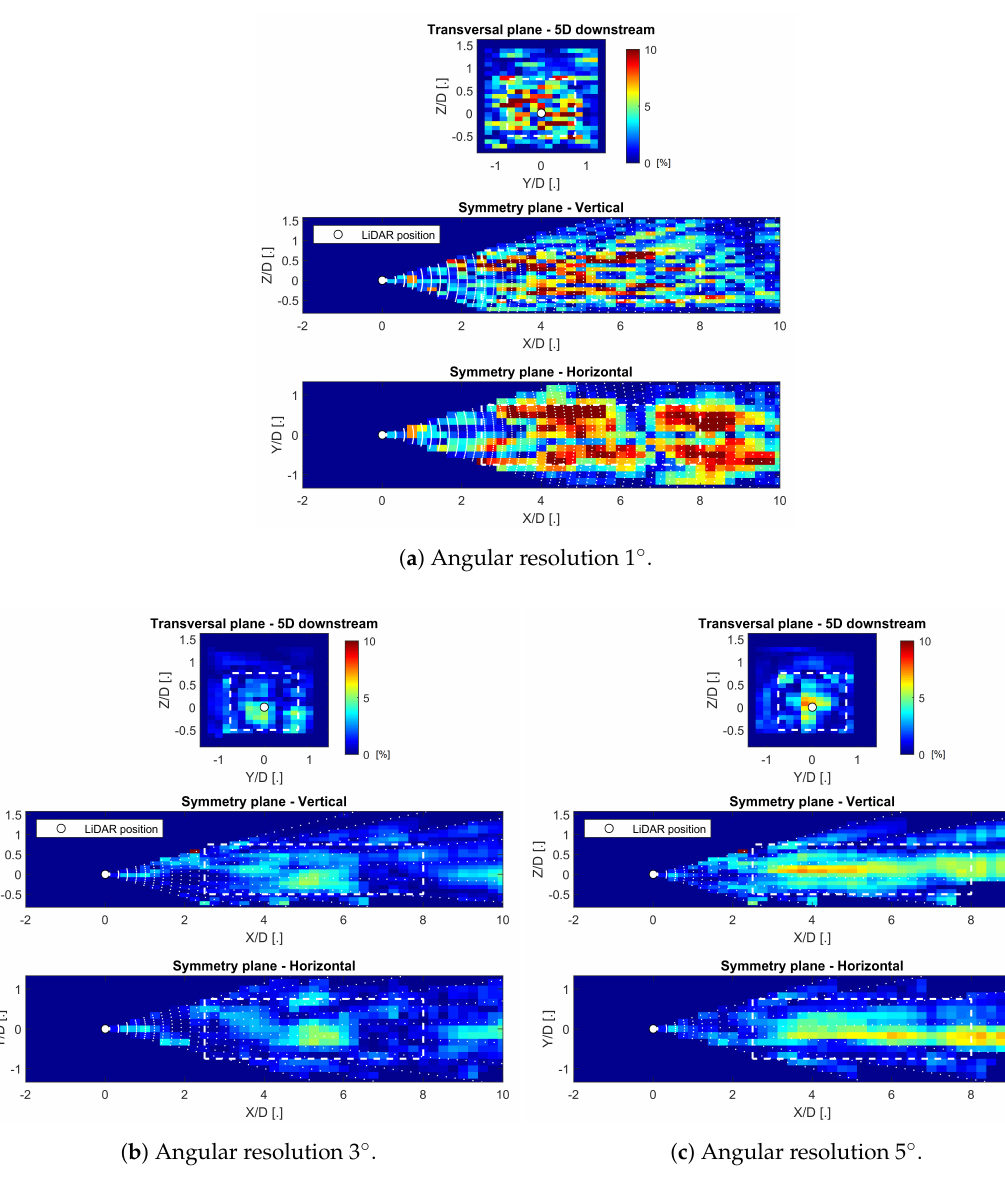
Figure 4. Example of total errors in the reconstruction of u ( x , y , z ) . The errors correspond to the MV-MT inflow case with the nacelle-mounted lidar and for three different angular resolutions: 1 ◦ ( a ), 3 ◦ ( b ), and 5 ◦ ( c ). The volume of interest is delimited by the white dashed line, and spherical grid points are marked as white dots. The figures show the error as a percentage of the undisturbed wind speed at hub height (see Section